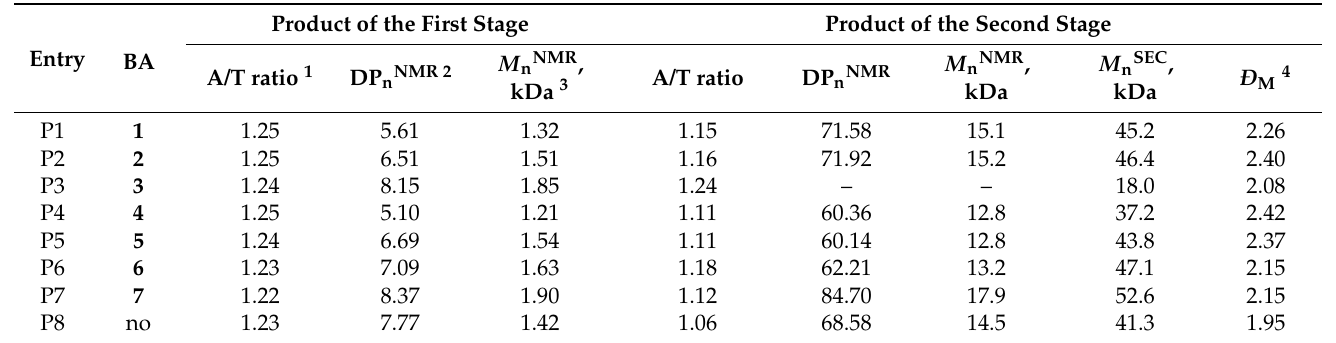
Table 1. Synthesis and characteristics of PBAT (first stage: 150–190 ◦ C, 760 to 1–2 Torr; second